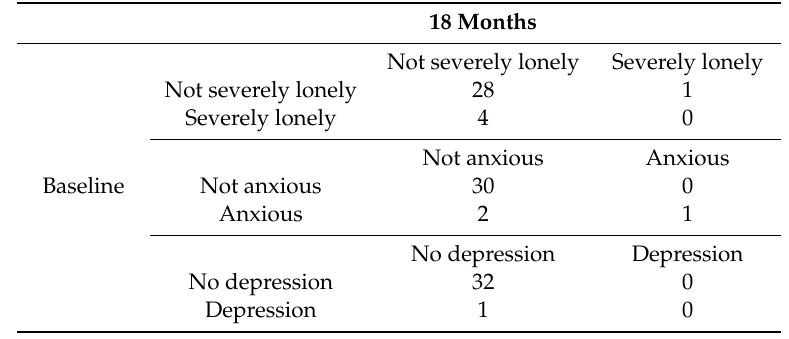
Table 13. Cross tabulation of outcomes for mood, social isolation and loneliness at baseline and at 18 months ( n = 33).